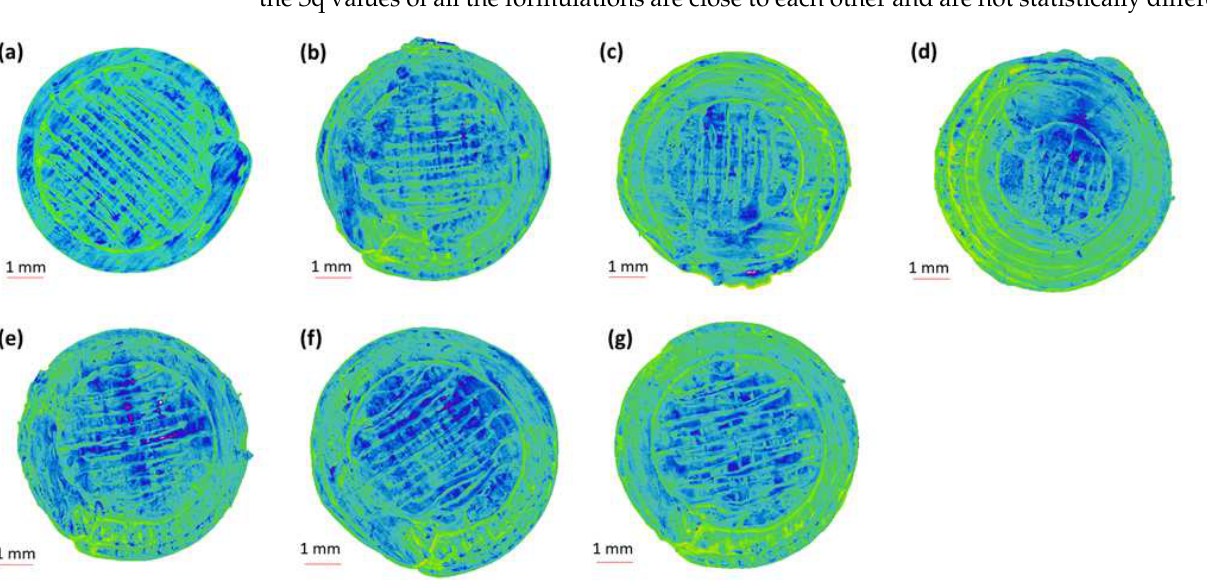
Figure 5. SEM micrographs of a 3D-printed tablet, namely F2 (2 shells with 0% infill): ( a ) whole matrix tablet; ( b ) side view of the matrix tablet; and ( c ) the side surface view.